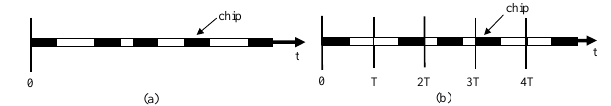
Figure 8: Principle of Time Hopping Spread Spec- trum (THSS)